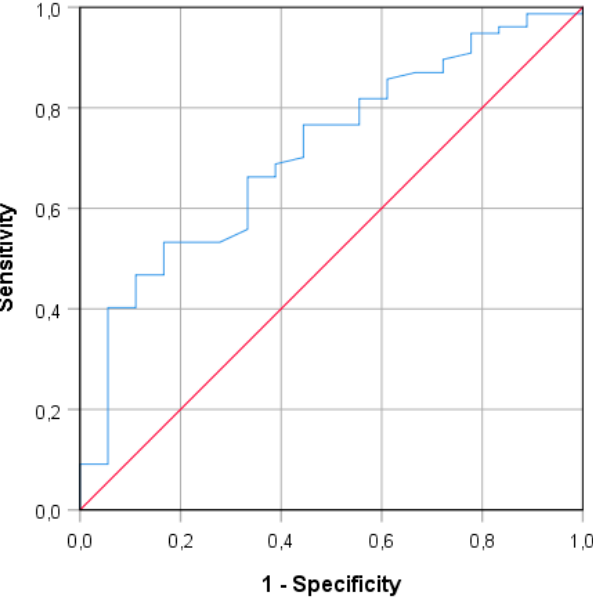
Figure 3. Receiver operating characteristic (ROC) curve for interpreting S/Co ELISA results in processing fluids.